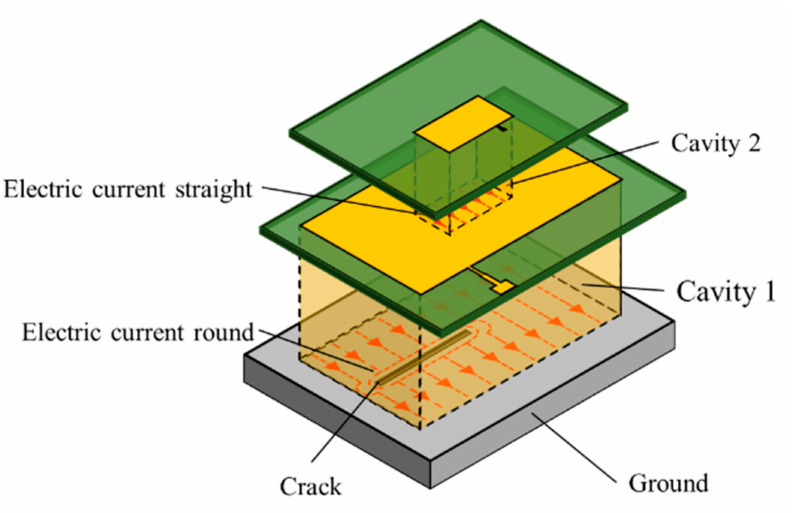
Figure 4. Schematic diagram of monitoring of strain and crack decoupling under multi-cavity model